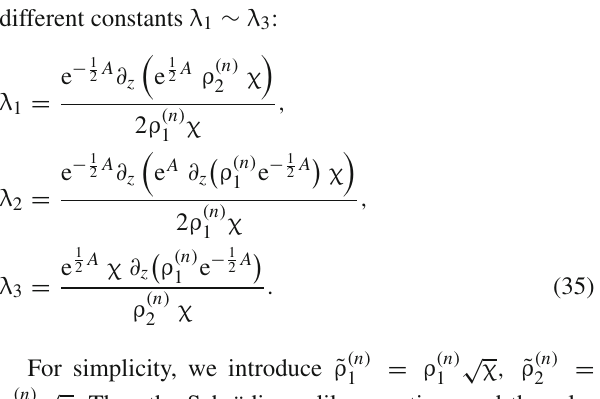
( n ) and ρ for bound vector and scalar KK modes with v = 1 , a = 1 , τ = 30 1 2